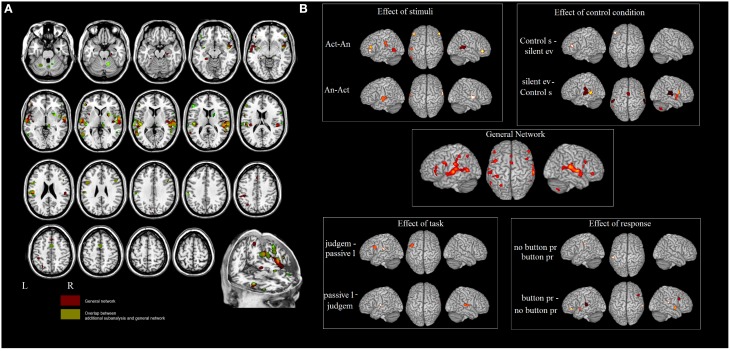
(A) Results of the ALE meta-analysis. The overlap between the general network and the networks found in meta-analyses 2–5 (in green). In red the areas not influenced by the external factors. (B) Influence of different design choices on the ES network.